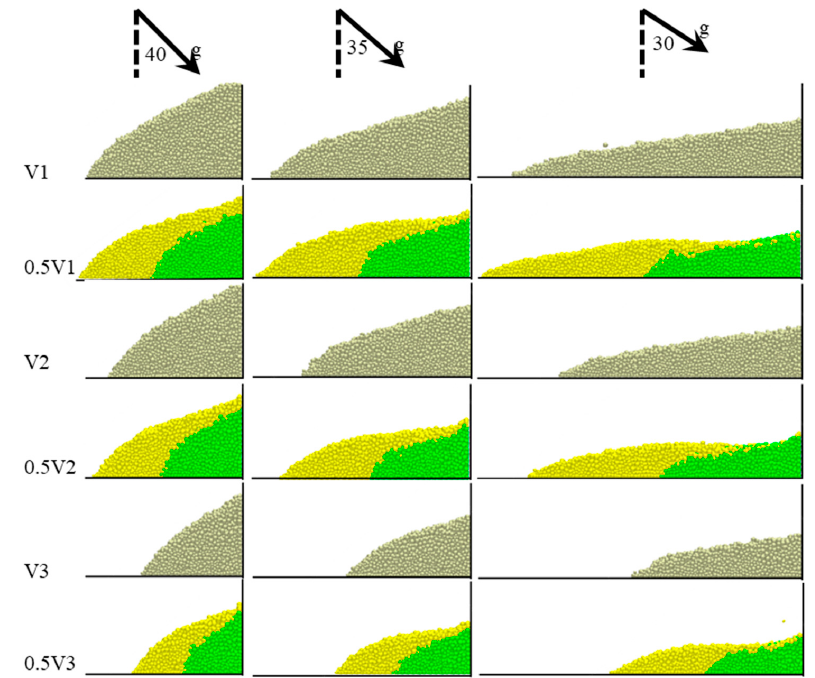
Figure 5. The final deposition morphology of the single-surge and multiple-surge impact for slope angles 40 ◦ , 35 ◦ and 30 ◦ and surge volumes V1 = 19.8 L, V2 = 15.84 L and V3 = 9.9 Table 3. Quantitative description of the effect of multiple-surge impact on the spreading distance of debris deposition.